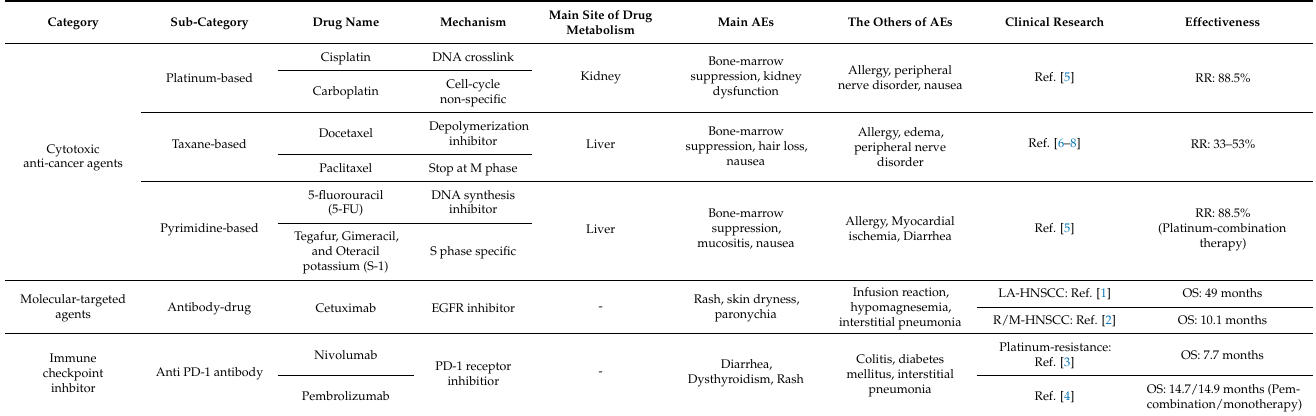
Table 1. Variation of anti-cancer drugs in